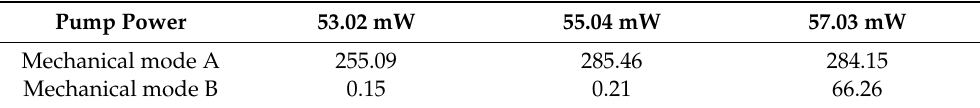
Table A1. Arithmetic square root of the generalized integral of the power spectrum for mechanical modes A and B at di ff erent pumping powers.